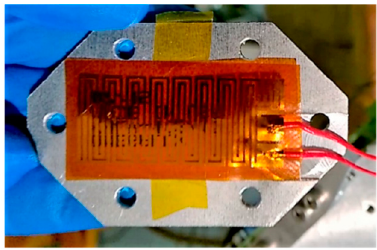
Figure 17. Omega patch heater attached by thermal fixation before installation.